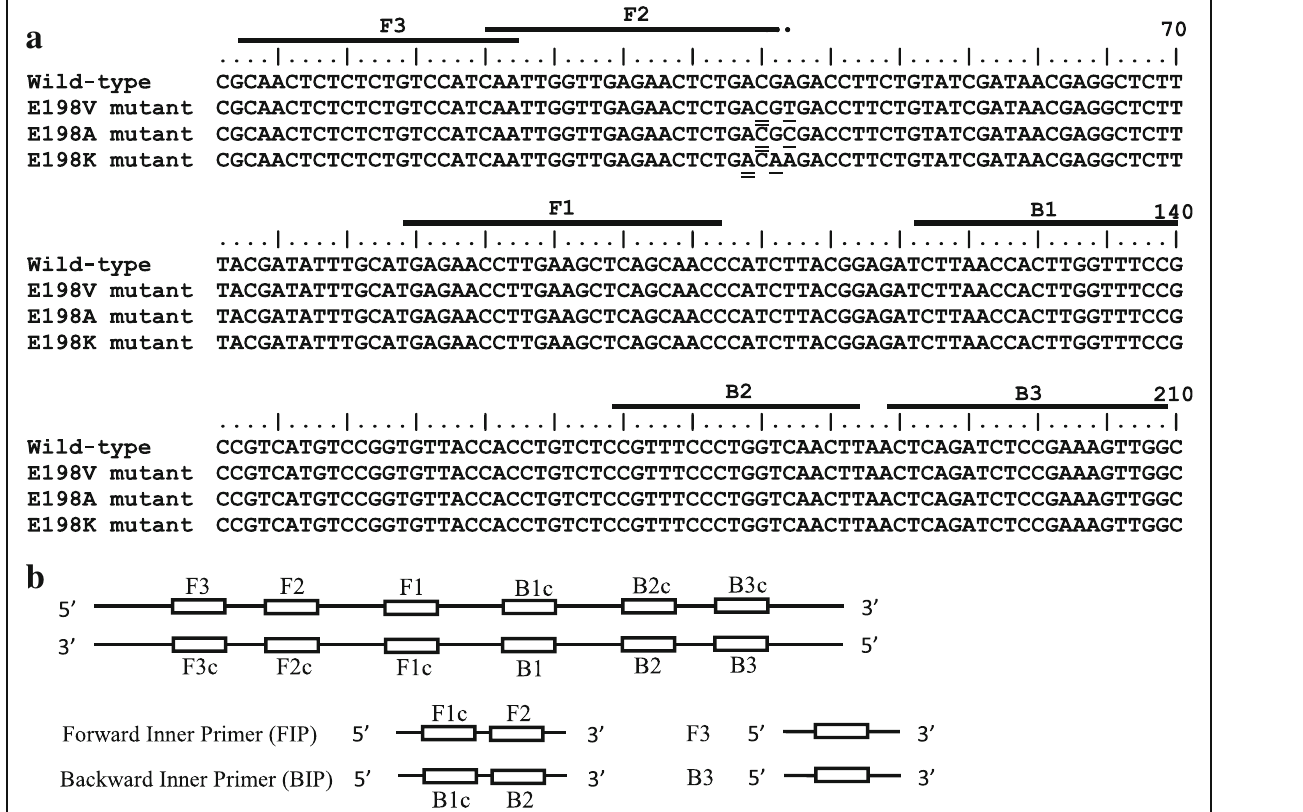
(Fig. 3a, b), indicating that the LAMP detection limit for plasmid pMD18-TubA was approximately 2 × 10 5 copies/ μ L. For conventional PCR, a 936 bp band was amplified when the template plasmid was diluted to as low as 2 × 10 3 copies/ μ L (Fig. 3c), illustrating that the detection limit of PCR was about two orders of magni- tude lower than that of LAMP.